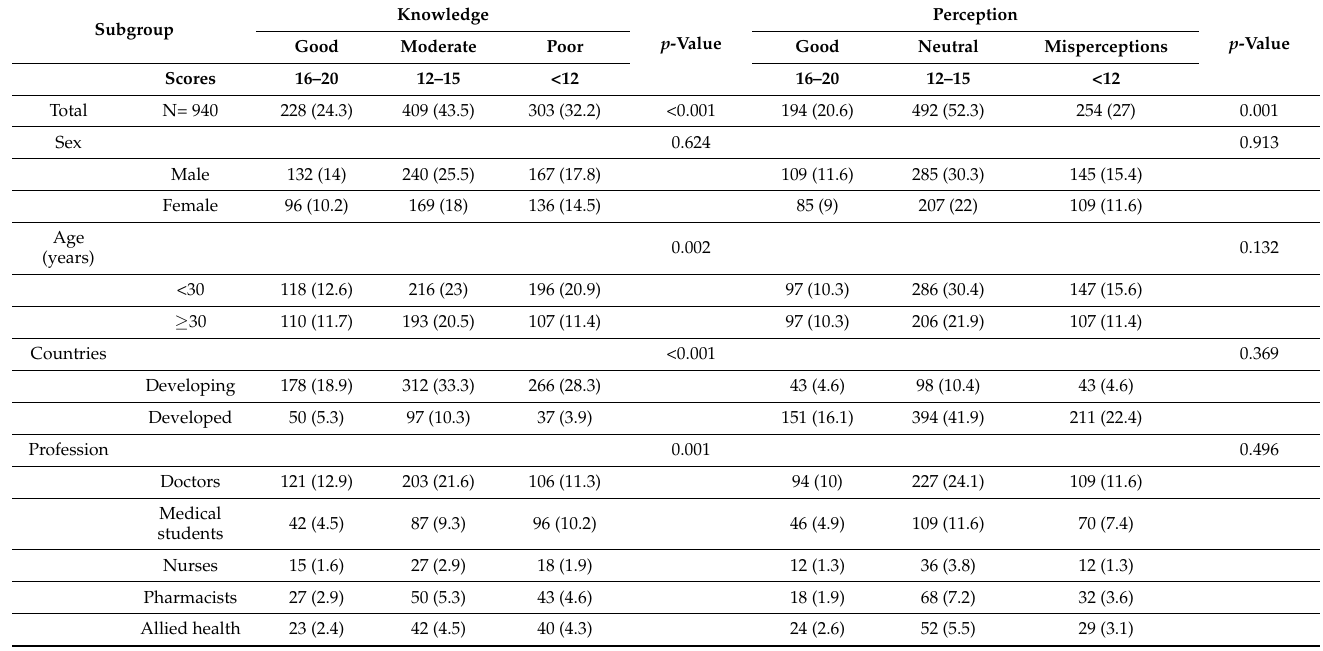
Table 4. Overall knowledge and perception levels across